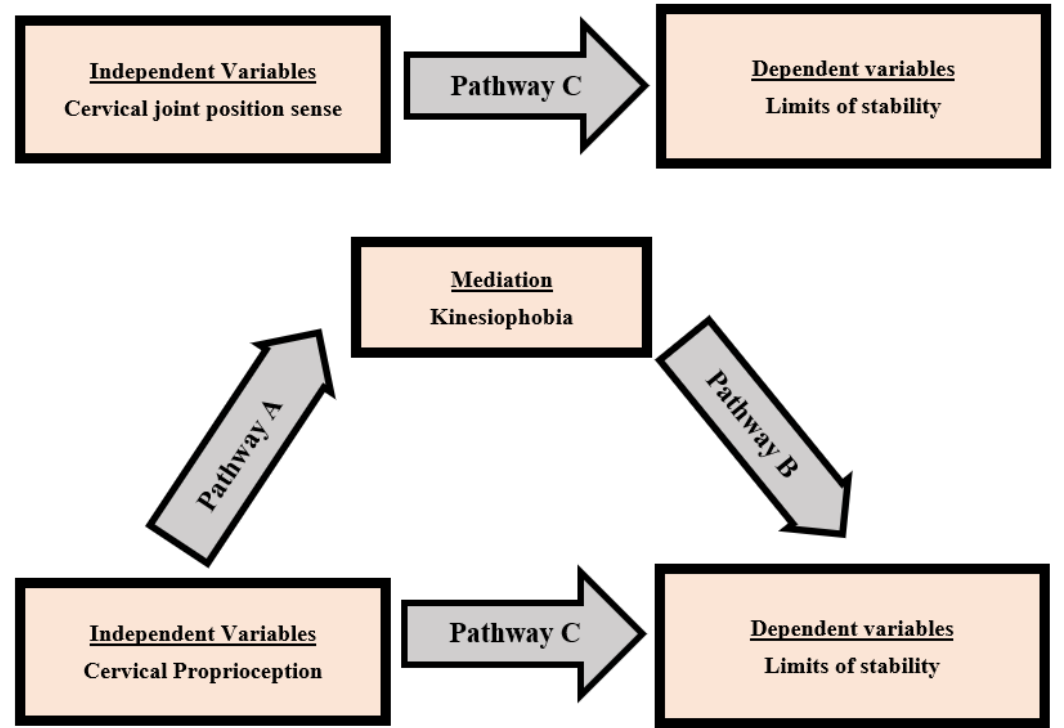
Figure 3. Model of the potential mediating effect of kinesiophobia on the relationship between cer- vical joint position sense and limits of stability. cervical joint position sense and limits of